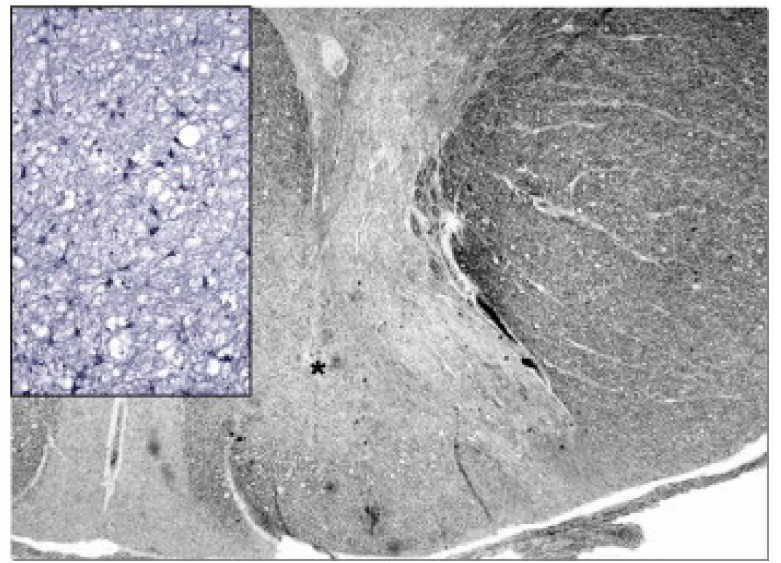
Figure 5. Neuropathology of the cervical spinal cord in a case of juvenile AHS. Both dorsal tracts, which carry deep sensation, are weakly stained (asterisk on the right one) and show intense gliosis (inset). Woelcke modified stain for myelin and GFAP immunohistochemistry (inset). Adapted from